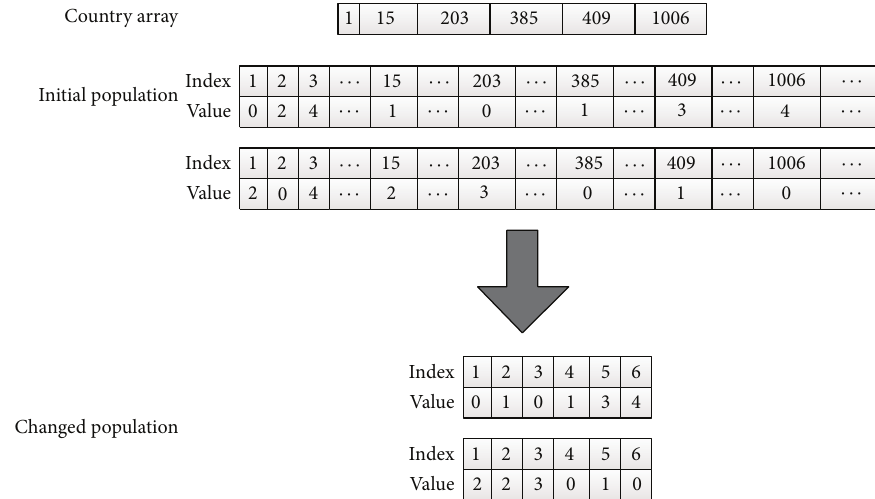
Figure 6: Initial population is changed in power function.